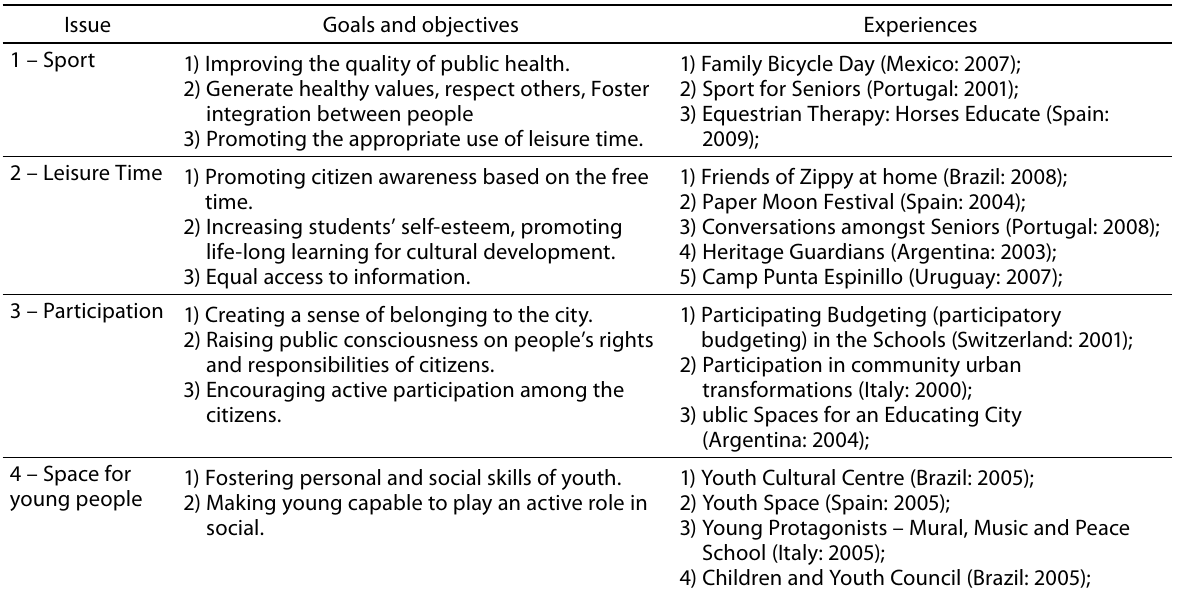
Table 1. Goals of analyzing experiences in the world